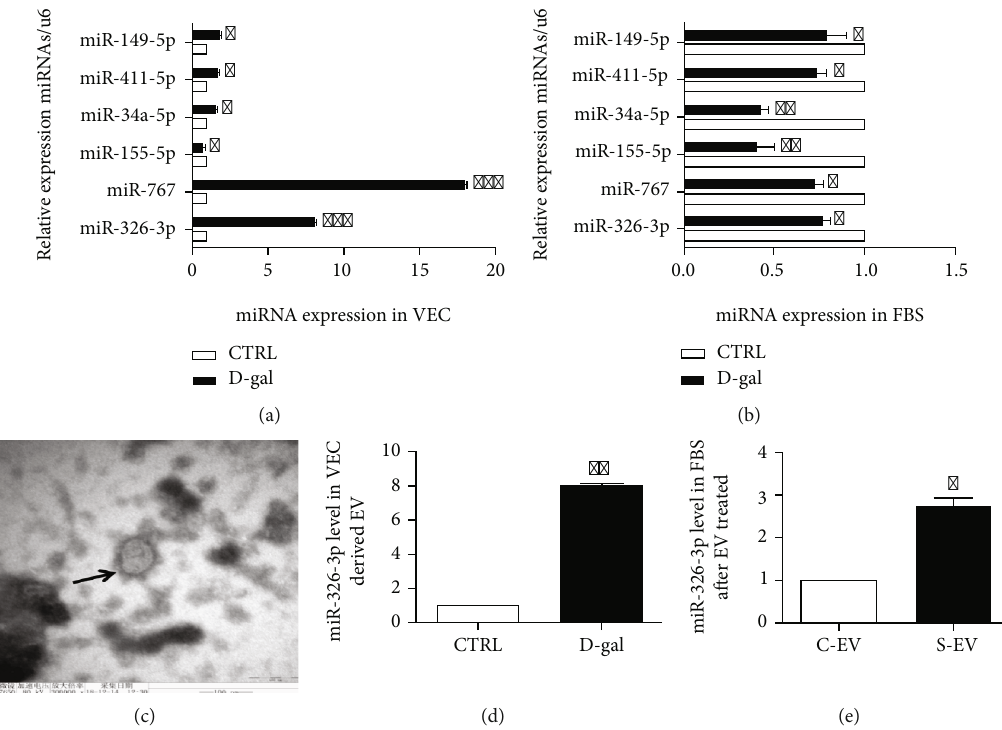
Figure 2: miR-326-3p overexpression in extracellular vesicles of senescence endothelial cells. (a) The expression of miRNAs associated with aging in vascular endothelial cells (VEC). (b) The expression of miRNAs related to senescence in skin fi broblasts (FBS). (c) Electron microscope observation of extracellular vesicles derived from vascular endothelial cells. (d) The miR-326-3p expression in extracellular vesicles (EV) of vascular endothelial cells (VEC). (e) The expression of miR-326-3p in skin fi broblasts after treated with endothelial cell- derived extracellular vesicles. ∗ p < 0 : 05 vs. CTRL; ∗∗ p < 0 : 01 vs. CTRL. ∗∗∗ p < 0 : 001 vs. CTRL. CTRL: control; D-gal: D-galactose; C- EV: control endothelial cell-derived extracellular vesicles; S-EV: senescent endothelial cell-derived extracellular